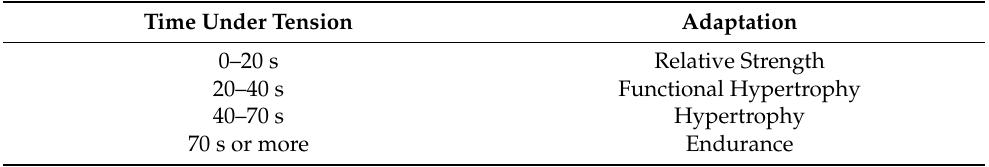
Table 2. Strength adaptation based on